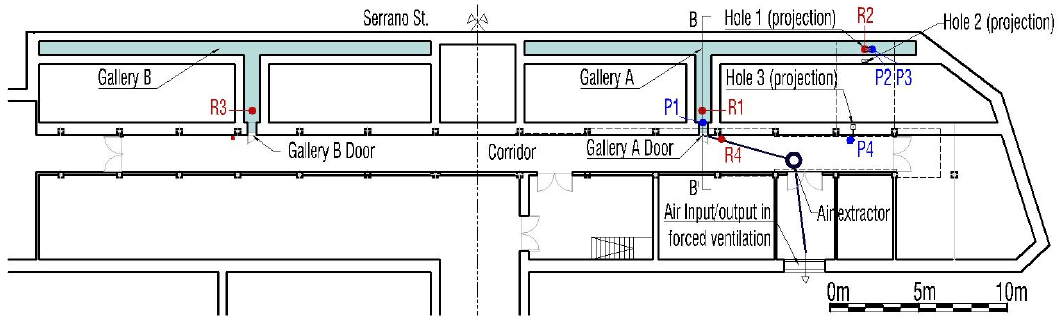
Figure 2. Plan of the basement with positions of spaces and sensors. Galleries A and B.